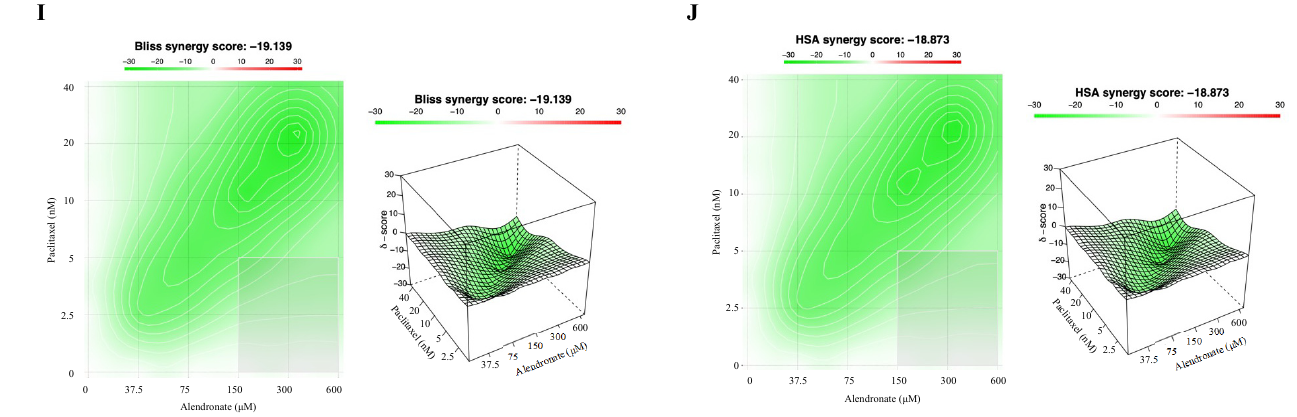
Figure 7. Combining Paclitaxel with repurposed drugs has an antagonistic effect on HOSE6.3 cells. ( A – J ) Bliss Independence and High Single Agent synergy 2D and 3D plots showing drug synergism of HOSE6.3 cells, after exposure to a fixed-dose ratio that corresponds to 0.25, 0.5, 1, 2 and 4 times the individual IC 50 values each drug, e.g., Paclitaxel combined with ( A , B ) Pitavastatin, ( C , D ) Metformin, ( E , F ) Ivermectin, ( G , H ) Itraconazole and ( I , J ) Alendronate for 48 h. The combined treatment was co-administered at the same time. All assays were performed in triplicate in at least three independent experiments. Synergy score: <10 (antagonism, green), =1 (additivity, white) and >10 (synergism, red).